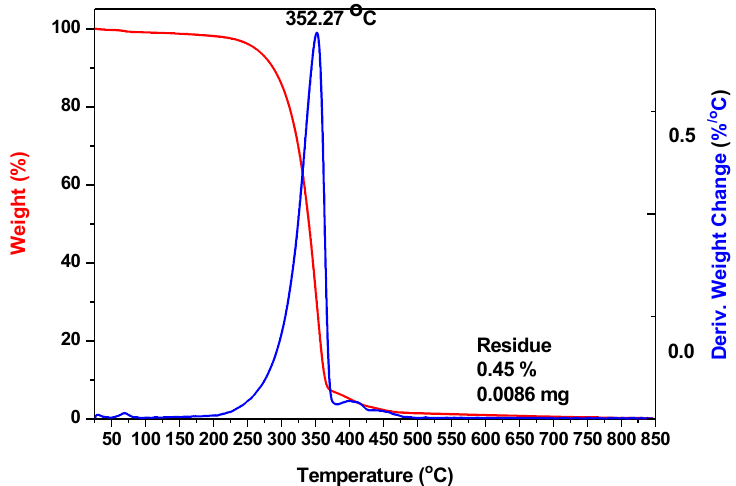
Figure 6. TGA graph of carbon nanotubes/polylactide composite; Residue is 0.45%.